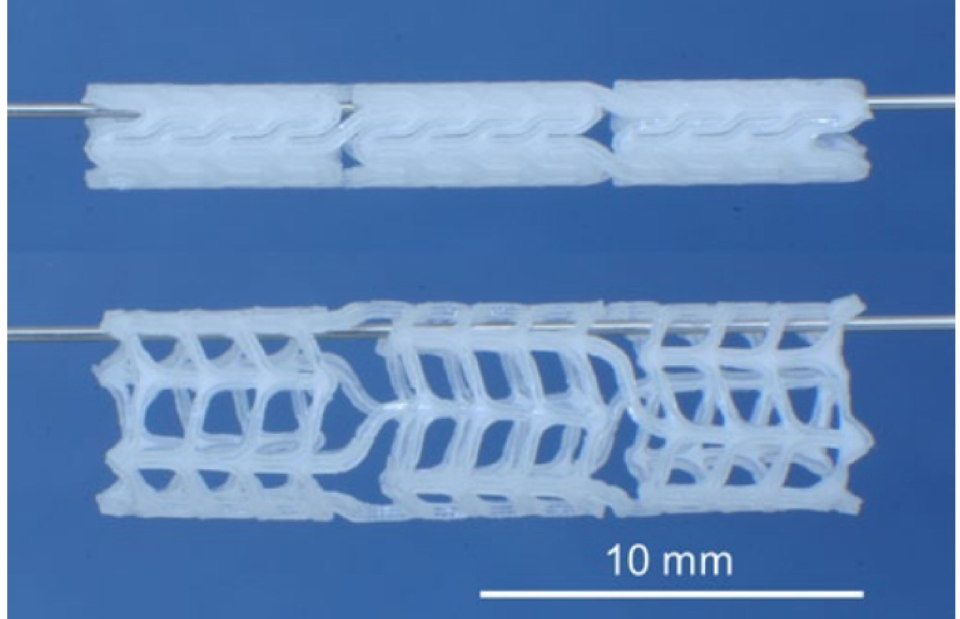
Figure 6. The biodegradable PLLA/P(4HB) stent unexpanded ( top ) and expanded ( bottom ). Reprinted from Kischkel et al. (2016)